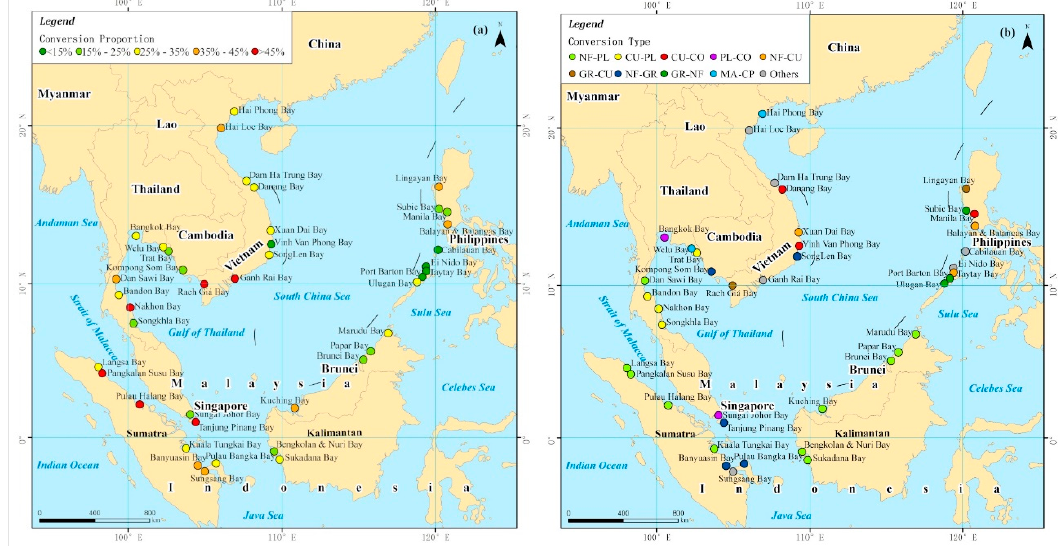
Figure 11. Overview of the land use conversion distribution. ( a ) The proportion of converted land area, ( b ) dominant land use conversion type.